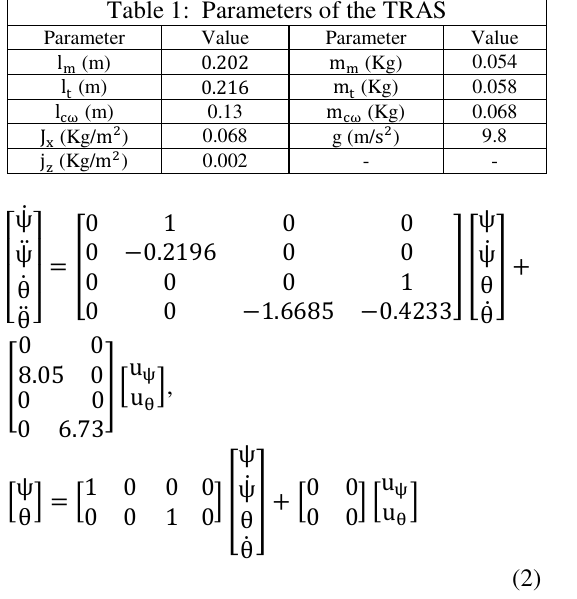
Table 1: Parameters of the TRAS